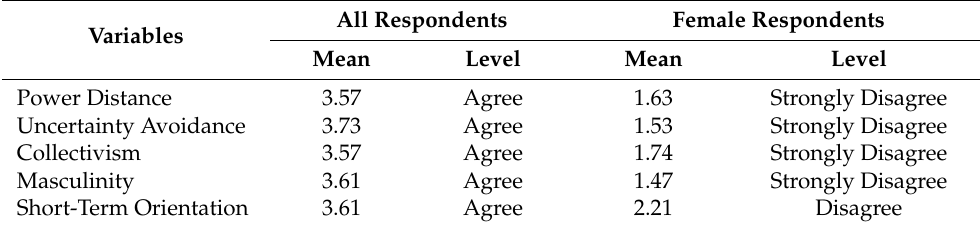
Table 3. Respondents to the dependent